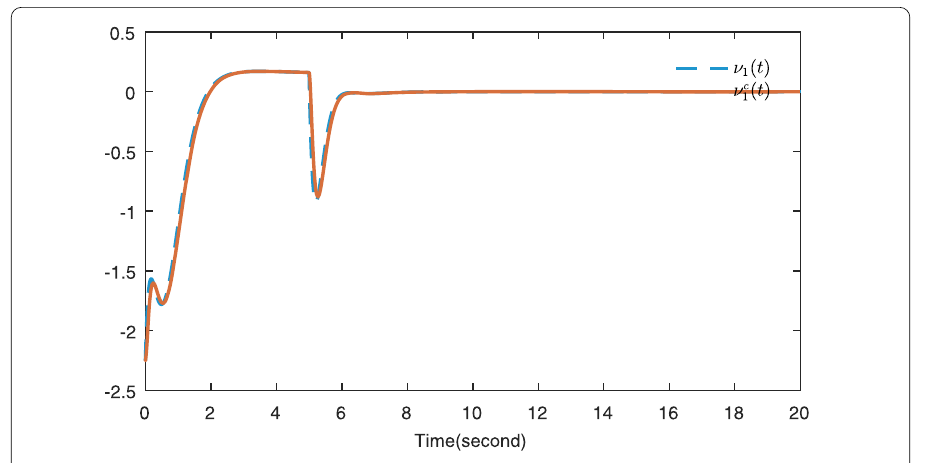
Figure 5 Virtual control input ν 1 ( t ) and its estimation ν c 1 ( t )